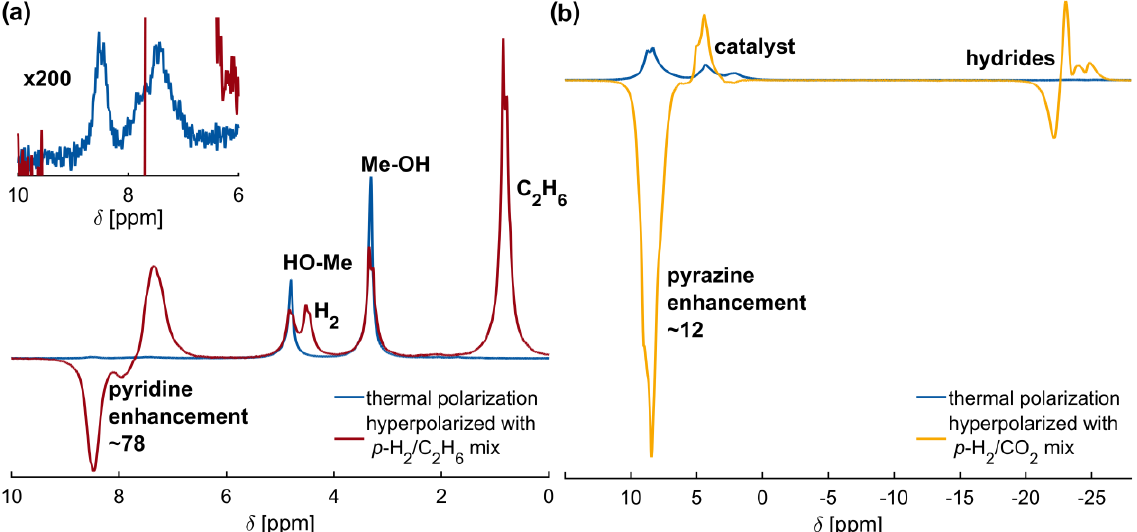
Figure 4. Parahydrogen hyperpolarization in quickly removable solvents. ( a ) 1 H NMR spectrum of pyridine in d -methanol hyperpolarized by liquefying a p -H 2 /ethane mixture with a signal enhancement of about 78 (red). The insert shows a 200-fold magnification of the thermal pyridine signal. The polarization transfer field for this experiment is the earth’s magnetic field. ( b ) Hyperpolarization of solid pyrazine and catalyst with a pressurized p -H 2 /CO 2 50:50 mixture at 200 bar. The achieved signal enhancement is about 12. Reference thermal polarization spectra are depicted in blue.